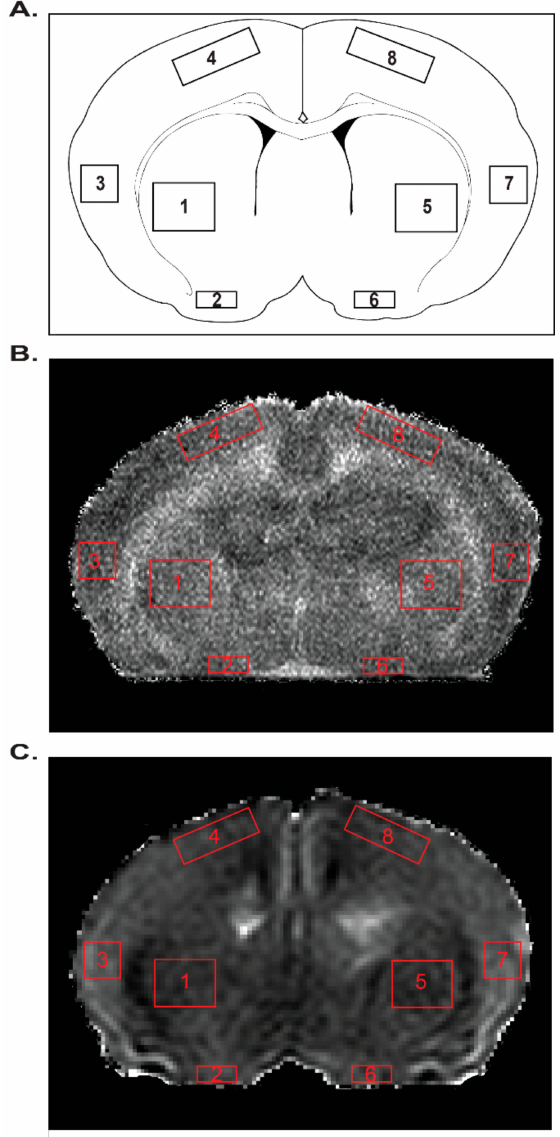
Figure 7. ( A ) displays the location of each of the four regions of interest in each hemisphere, as marked by numbered red boxes on a coronal section from an anatomical map at Bregma level 0.20 mm. Regions of interest 1–4 represent the left striatum, ventral cortex, lateral cortex, and dorsal cortex, respectively, whereas regions of interest 5–8 represent the right striatum, ventral cortex, lateral cortex, and dorsal cortex, respectively. ( B ) shows a T2 map and ( C ) an ADC map from the brain of a P11 MUN Untreated-Sham